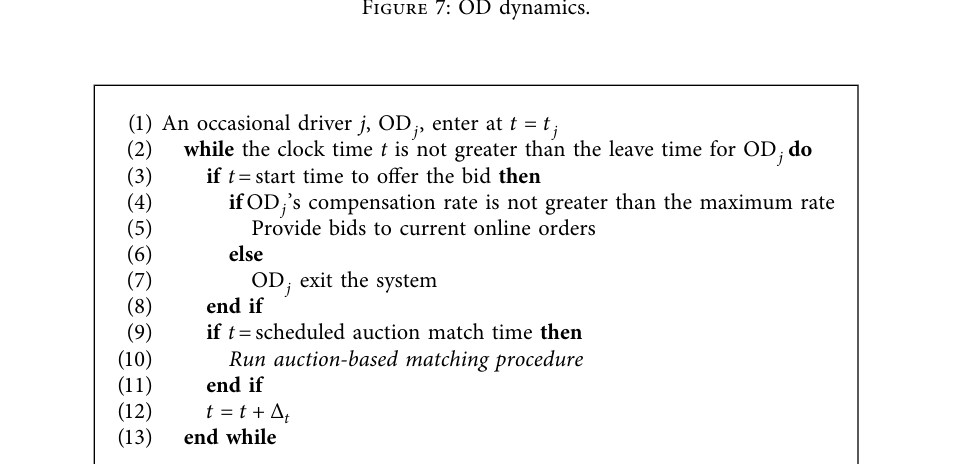
) : The number of matched (6) Order matching rate ( R order online orders divided by the total number of online orders announced (reported as a percentage).